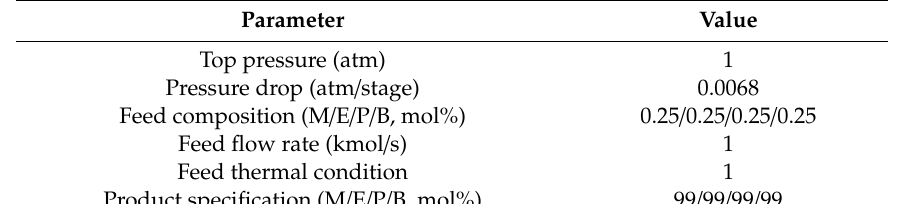
1. Table 1. Nominal Operating Conditions and Product Specifications to the methanol(M) / ethanol(E) /